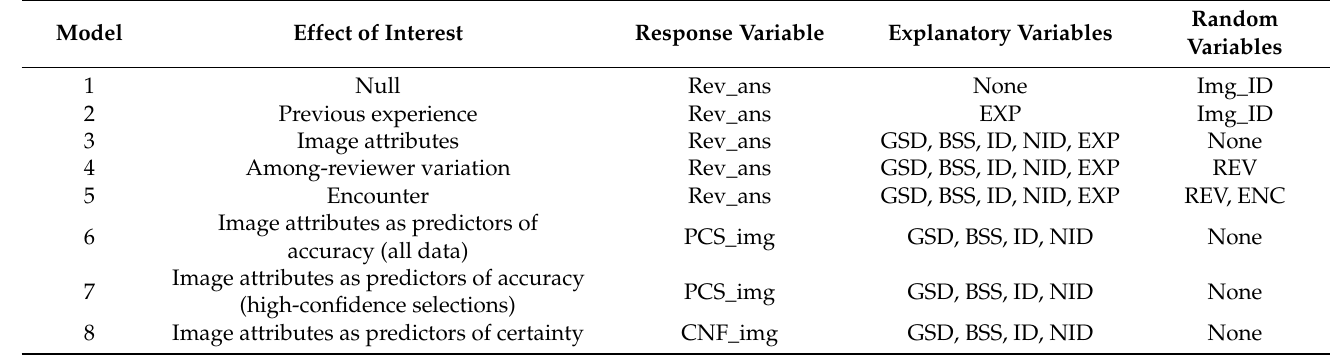
Table 2. Description of statistical models used to predict the accuracy and certainty of